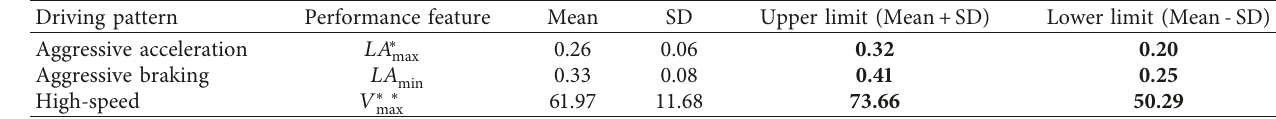
Table 10: Cluster characteristics of data-driven critical driving